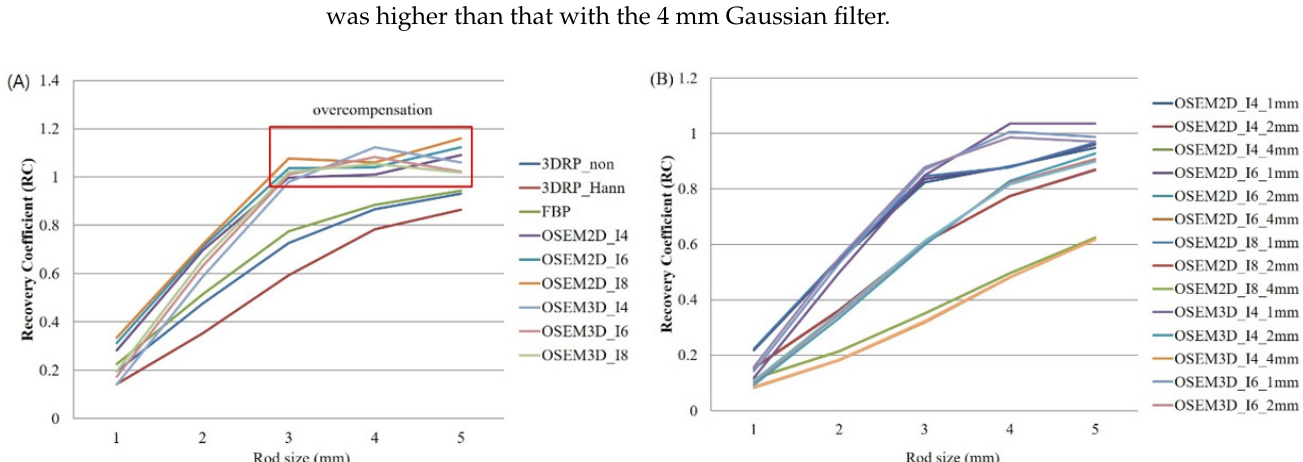
Figure 4. The spillover ratio (SOR) was estimated as the mean of uniform area to the mean of water or air area. ( A ) The SOR in water was significantly higher than that in air in the reconstruction methods without Gaussian post-filtering ( p < 0.001). ( B ) In the iterative methods, SOR decreased with increasing iteration number and increased with increasing Gauss- ian filter size ( p < 0.05).